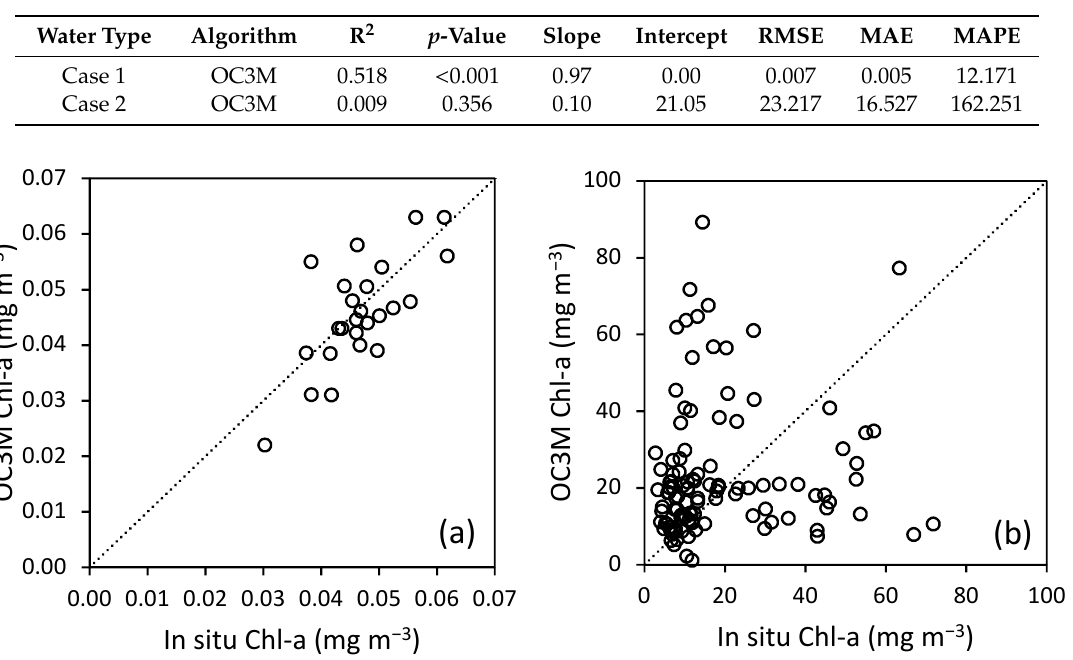
Table 3. Statistics assessing accuracy of Ocean Color 3M (OC3M) derived Chl-a in Sargasso Sea (case 1) and Chesapeake Bay (case 2) water.